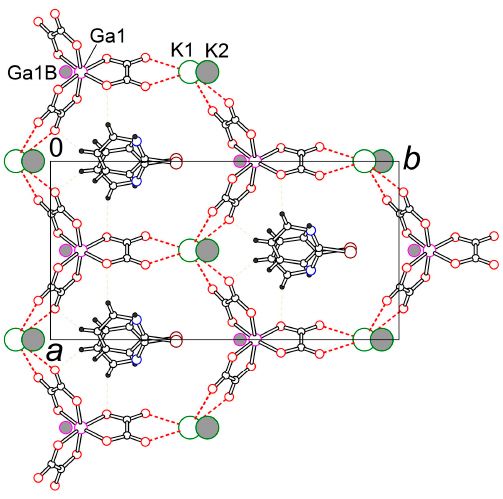
Figure 3. Anion layer in 4 . K2 and Ga1B atoms of minor occupancy are shown in grey; oxalate groups of minor part of the anions are omitted for clarity.